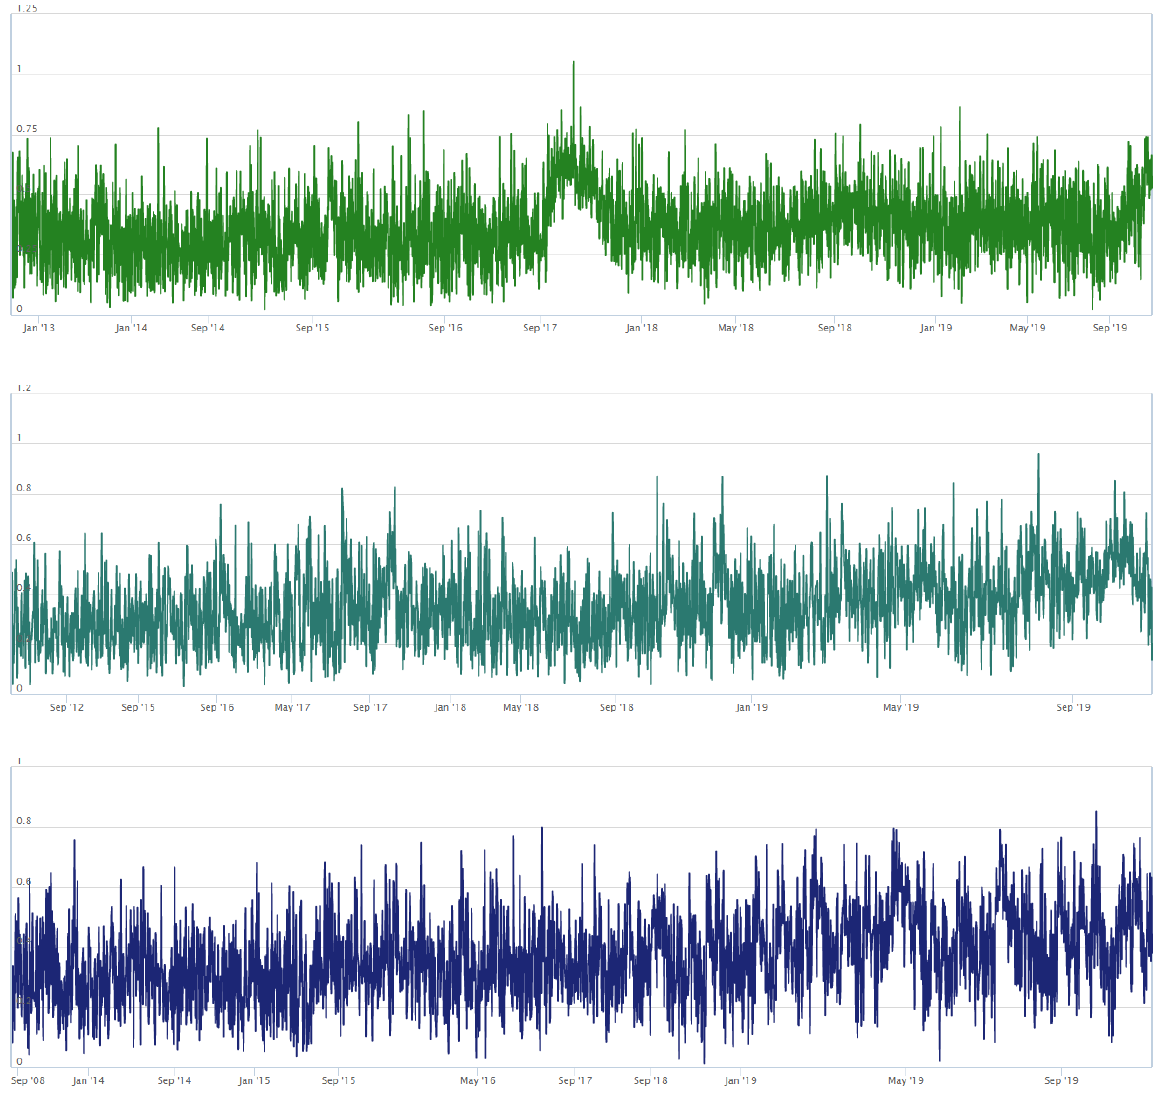
Figure 1. Polarization through time: Catalonian independence, climate change and political parties (from top to bottom).